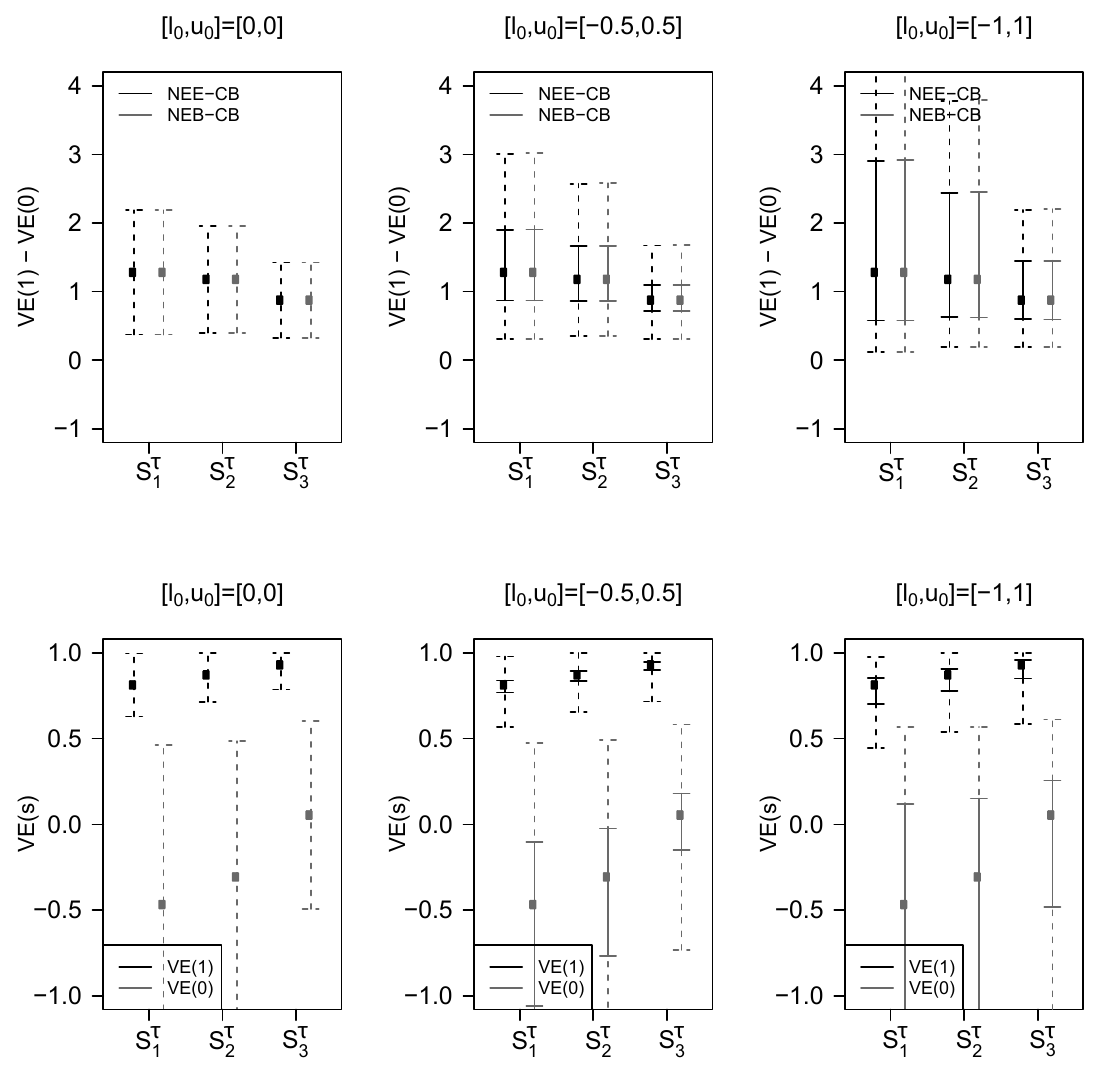
Figure 2: For HVTN 505, ignorance intervals (solid lines) and 95% EUIs (dashed lines) for VE (0) = CEP (0, 0) and VE (1) = CEP (1, 0) and µ = VE (1) − VE (0) with binary Month 6.5 biomarker S τ equal to 1 (0) if the vaccine recipient expresses (does not express) the CD8+ T-cell subset defined by expression pattern ( S τ 1 ) ( − , − , − , − ,+,+), ( S τ 2 ) (+, − , − , − ,+,+), or ( S τ 3 ) (+, − ,+,+, − ,+).